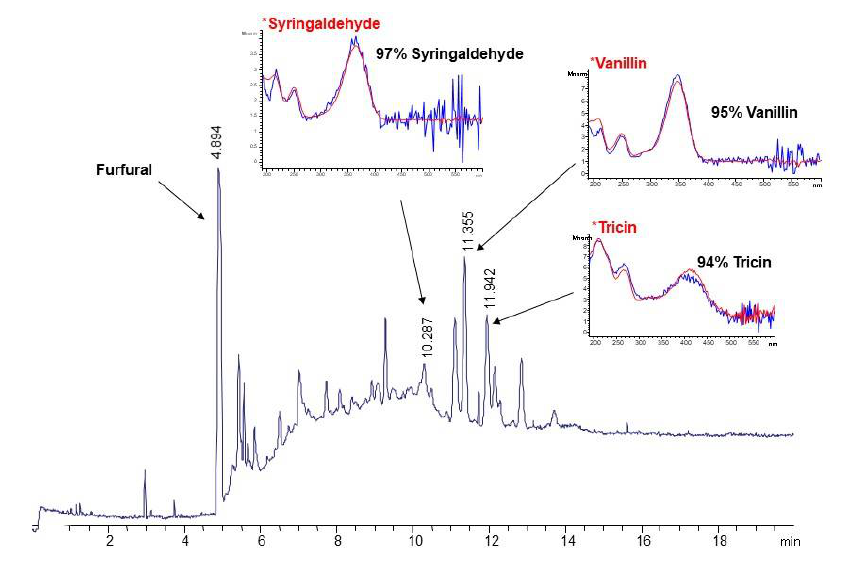
Figure 6. Electropherogram showing the phenolic profile for non-catalysed ethanol organosolv washing solution from wheat straw (190 ◦ C, 120 min). Matching was obtained via comparison with authentic standards (*) run under the same conditions as the